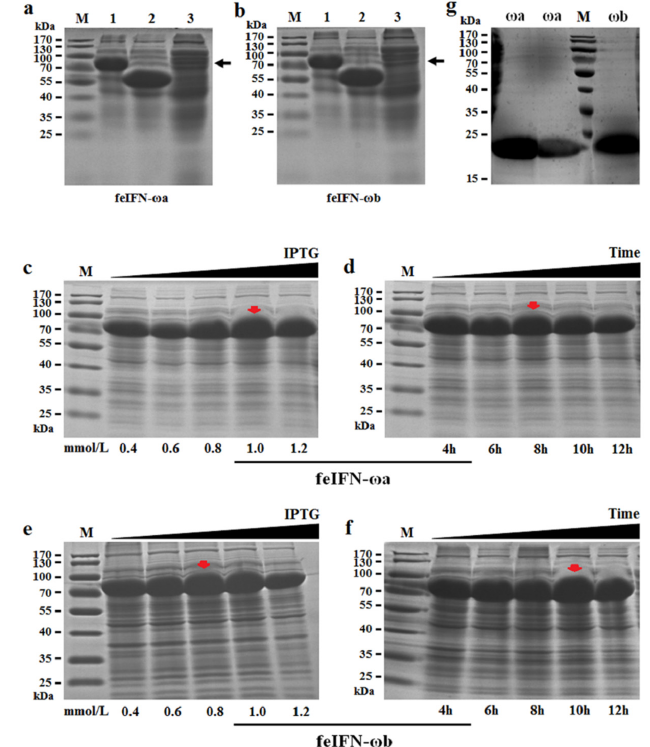
Figure 4. Expression and purification of recombinant feIFN- ω proteins from E. coli . ( a , b ) The fusion proteins were expressed from pCold-feIFN- ω a/BL21 ( a ) and pCold-feIFN- ω b/BL21 ( b ) in their soluble forms. M: Protein Marker; Lane 1: fusion protein rfeIFN- ω a+TF ( a ) and fusion protein rfeIFN- ω a+TF ( b ); Lane 2: TF tag expressed by pCold-TF/BL21; Lane 3: noninduced pCold-feIFN- ω a / BL21 ( a ) and noninduced pCold-feIFN- ω b / BL21 ( b ). ( c , d ) Optimization of the IPTG concentration ( c ) and induction time ( d ) conditions for expression of the rfeIFN- ω a protein from the pCold-feIFN- ω a / BL21 E. coli . ( e , f ) Optimization of the IPTG concentration ( e ) and induction time ( f ) conditions for expression of the rfeIFN- ω b protein from the pCold-feIFN- ω b / BL21 E. coli . ( g ) The rfeIFN- ω a and rfeIFN- ω b proteins were purified by His-tag Ni 2 + a ffi nity column chromatography. The black arrow represents the target fusion protein and red arrowhead represents the target fusion protein expressed under the optimized